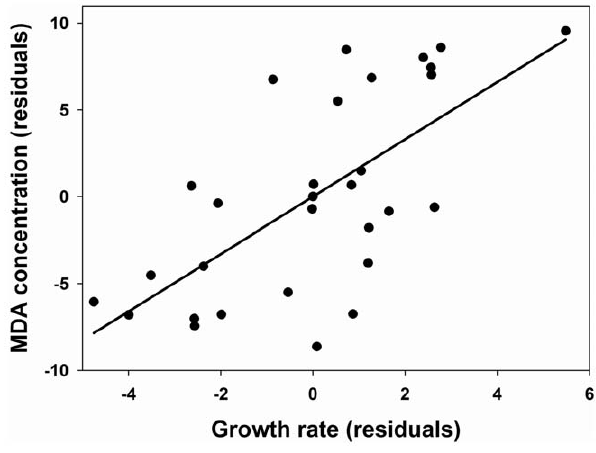
Figure 1. Relationship between MDA concentration (lipid peroxidation) and mass gained. The residuals, after controlling for treatment (time begging), nest (random), and date, are shown. The regression line is shown.